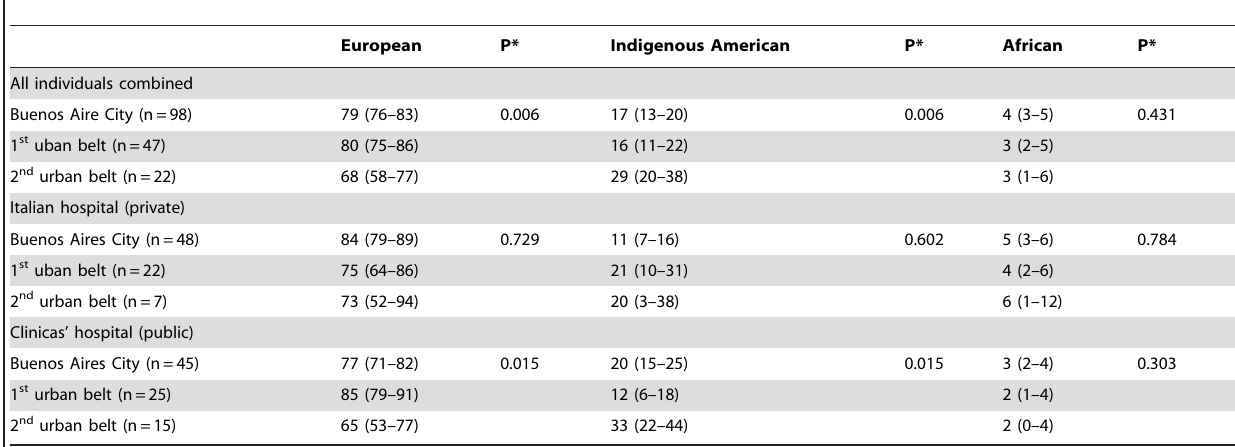
Table 1. Average individual ancestry for Buenos Aires metropolitan area, Mean (95%